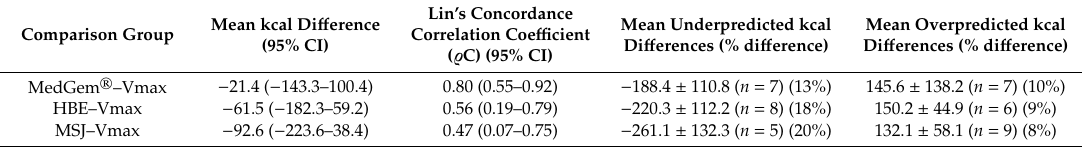
Table 3. Mean REE using different devices compared to Vmax.